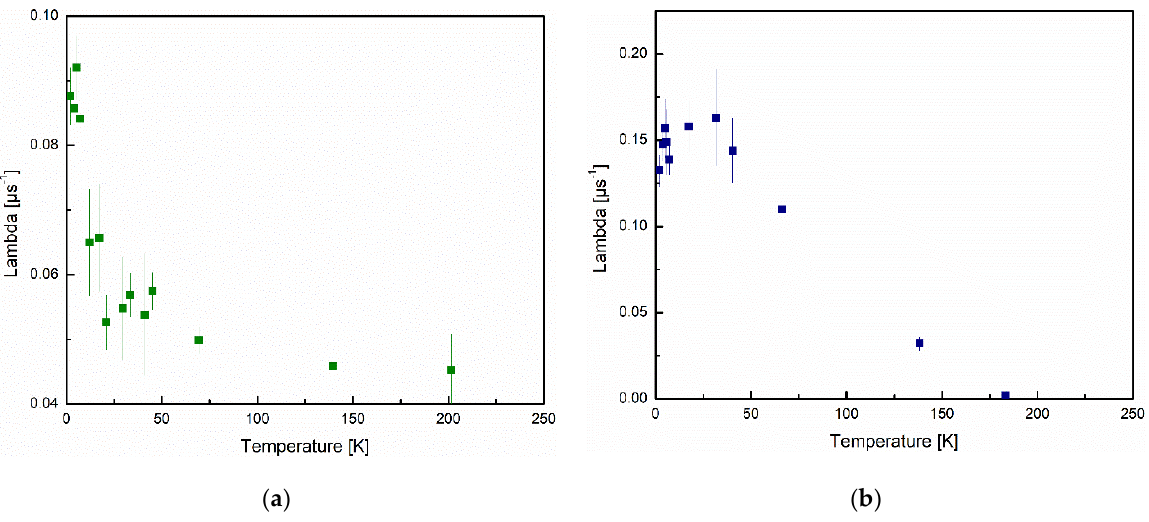
Figure 10. Relaxation rate of the stretch exponential component of the ZF fit for ( a ) samples 1; ( b ) sample 2, as a function of temperature.